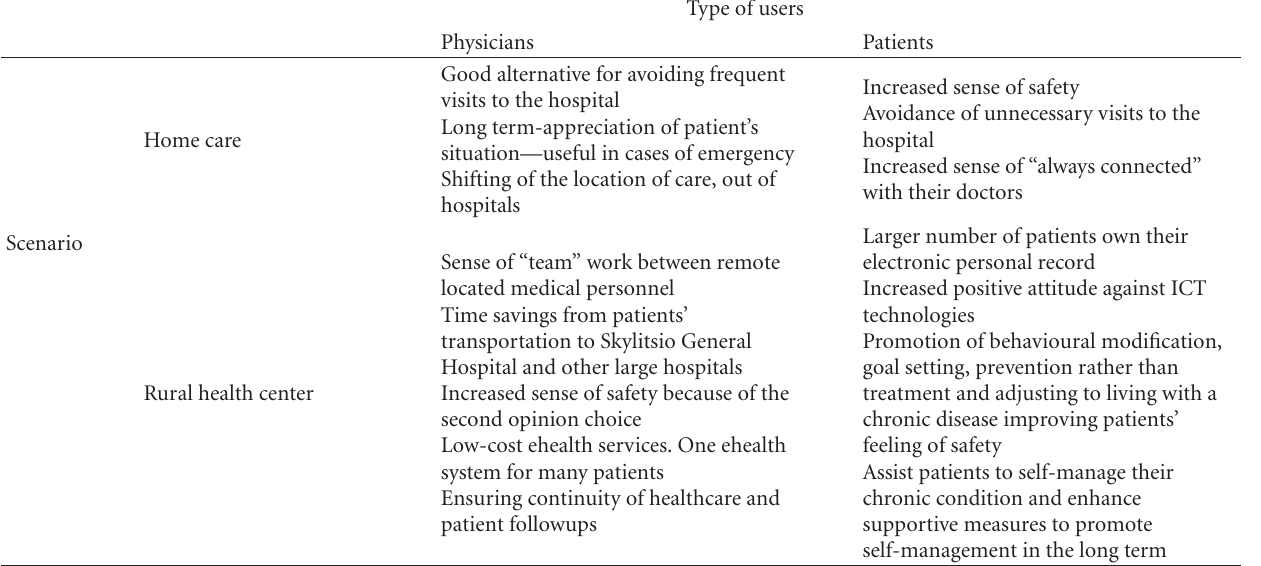
Table 3: Perceived benefits of Tile-Ippokratis